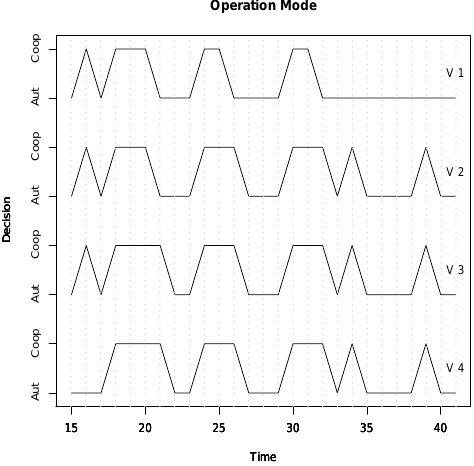
Figure 2. Vehicle behavior under frequent communication failures. The plot shows the decision that four vehicles took among two operation modes during 25 rounds using Algorithm